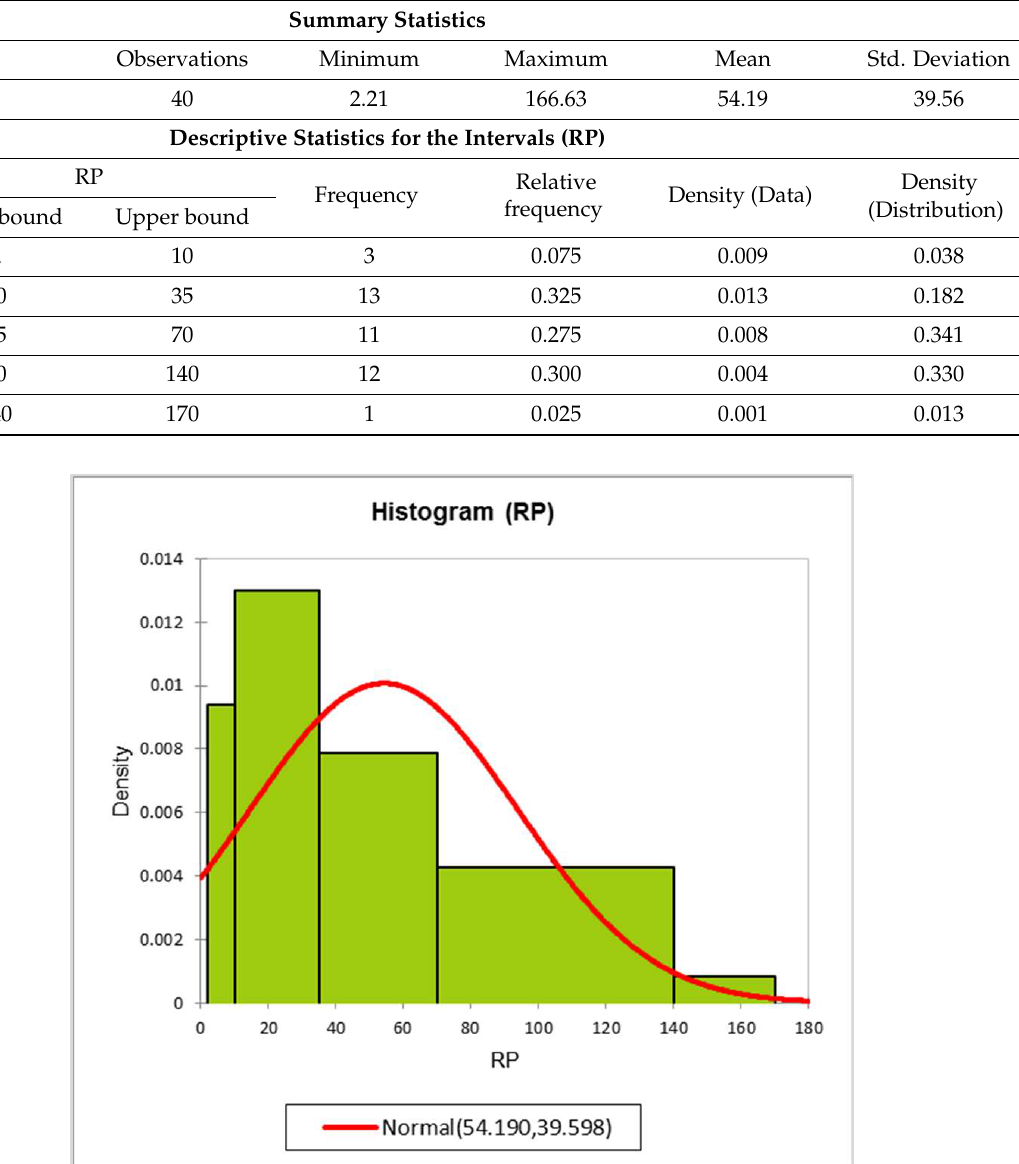
Figure 11. Histogram of Neznal categorisation indexes. Redline shows the normal distribution. Figure 12 shows the distribution of calculated radon index values produced using the nearest neighbour interpolation method. Similar to the map of predicted radon potential in Figure 9, areas with high geogenic radon risk are located within the northwest and southeastern confines of the study area. Although among the scientific society, Neznal’s method has been proven to be an acceptable approach to formulate the radon potential, it is based on soil gas radon concentrations and permeability alone. Here, we apply a well-recognised and robust spatial regression model where a set of effective parameters are introduced as inputs to map radon potential [13]. We see the two approaches as complementary in nature, with the advantage that the spatial regression model includes a greater number of variables to define areas of geogenic radon